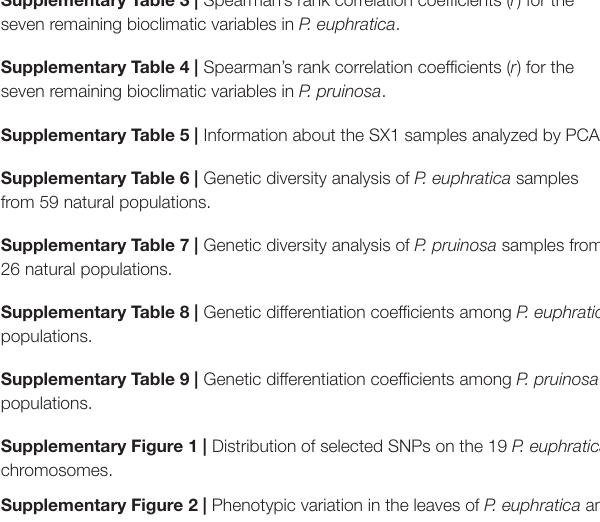
Supplementary Table 2 | The primers used for each target SNP site.